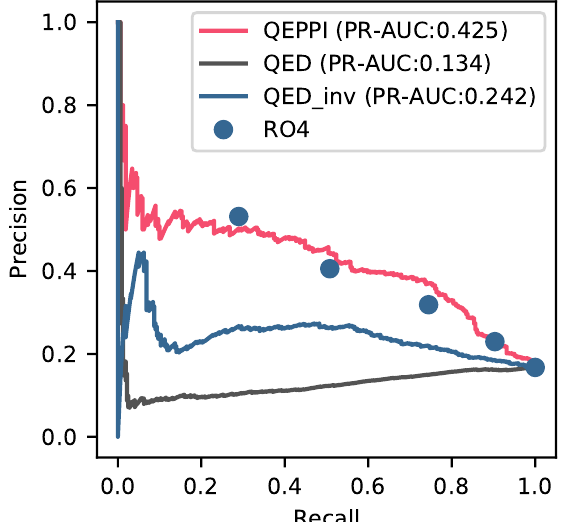
Figure 4. Comparison of QEPPI with RO4 in a Precision-Recall curve. The Precision-Recall curve shows Precision against the Recall value, which describes differences in performance for classifying compounds as PPI-target compounds. The red, black, and blue lines represent the Precision-Recall curves for QEPPI, QED, and 1 − QED (QED_inv), respectively. The five blue dots represent the points that allowed 0 to 4 violations of